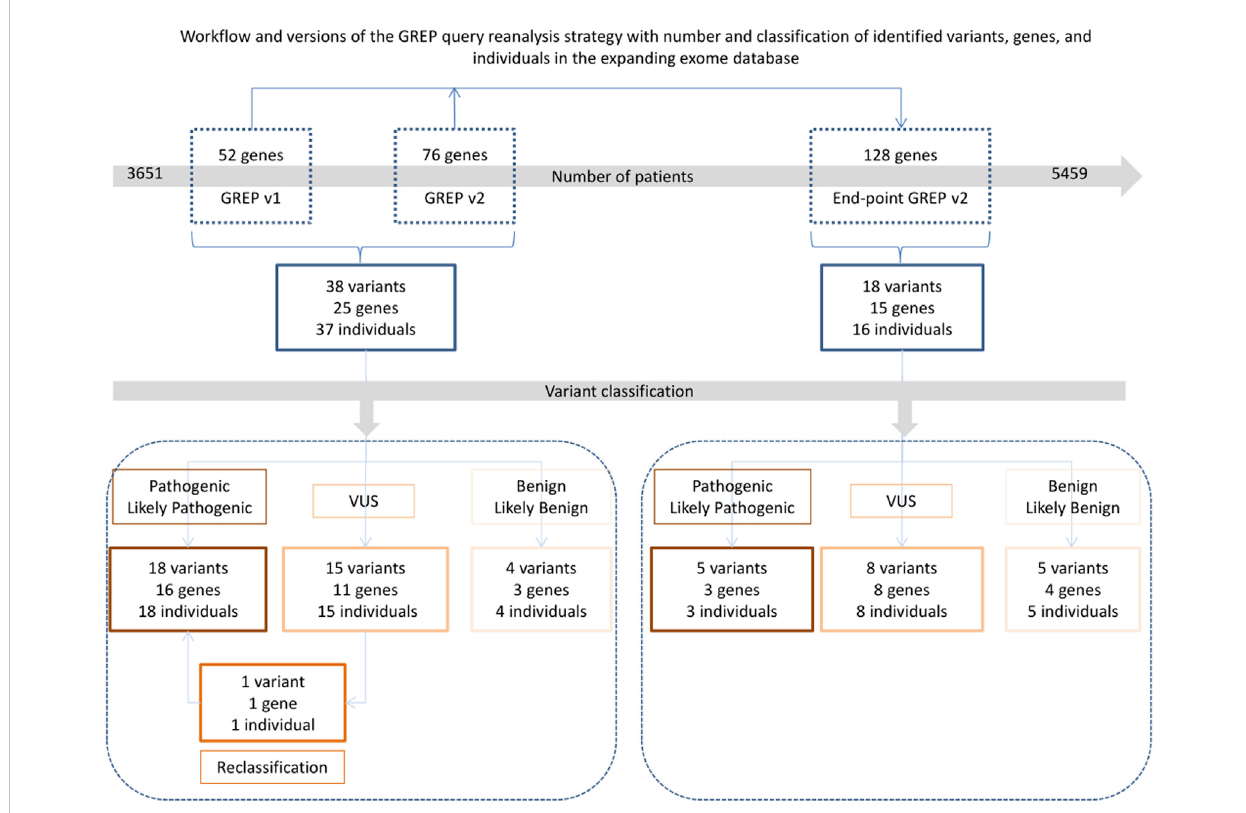
FIGURE 5 Work fl ow and version of GREP query used according to the amount of ES data searched, with the number and classi fi cation of identi fi ed variants, genes, and individuals. A CSNK2B variant was fi rst classi fi ed as of unknown signi fi cance but subsequently reclassi fi ed as likely pathogenic after a later publication. VUS: variant of unknown signi fi